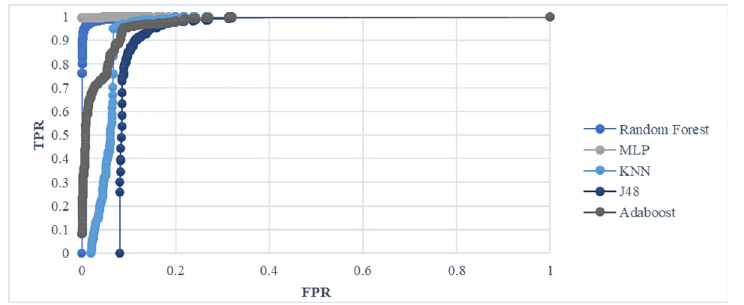
Fig 8. Receiver operating characteristic